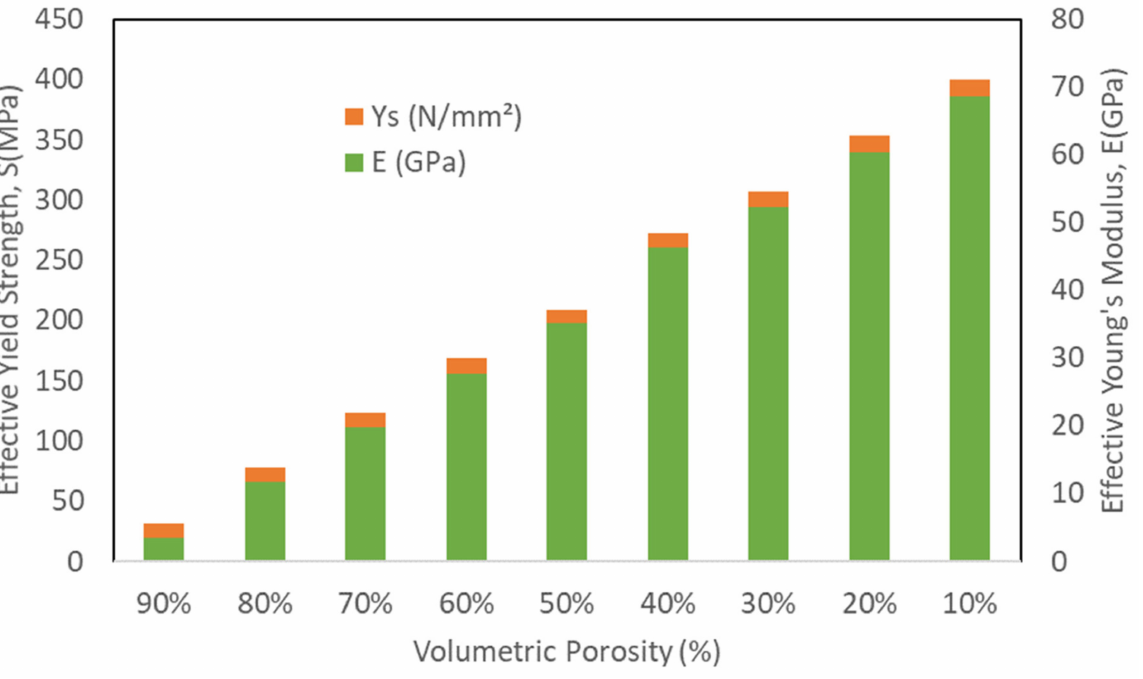
Figure 5. Finite element analysis mechanical properties of the porous structures under compres- sion